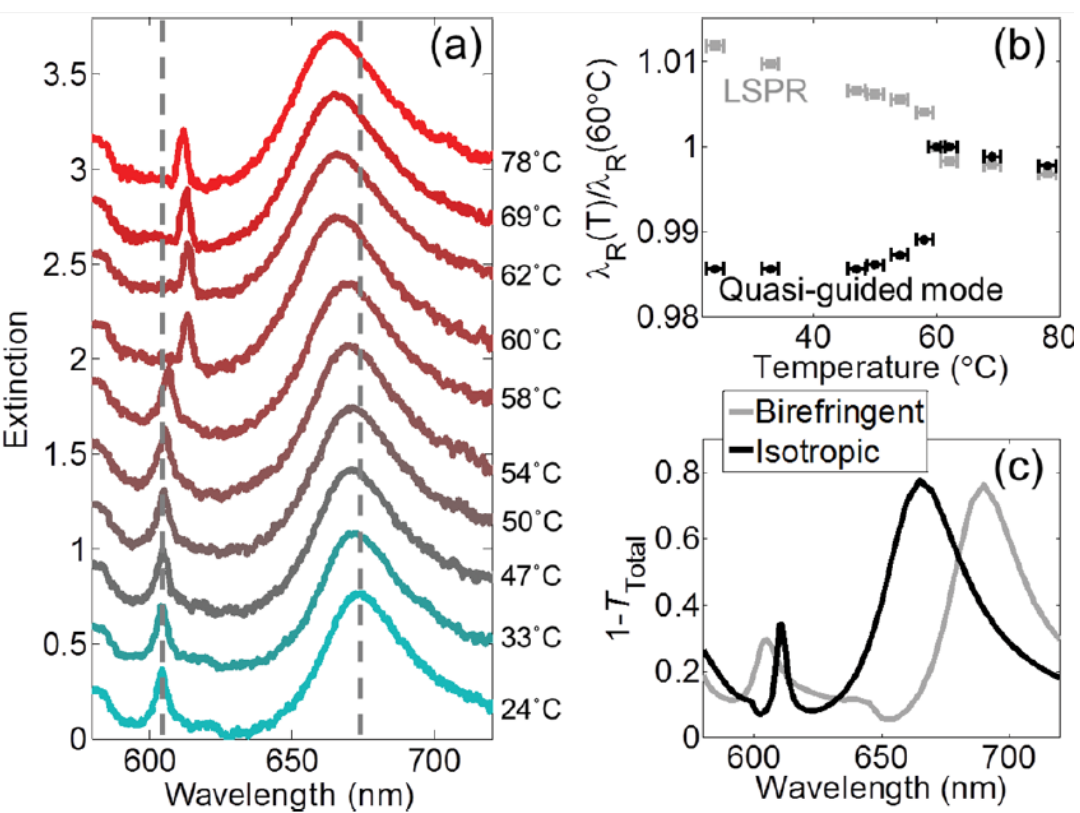
Figure 11. ( a ) Measured extinction as a function of wavelength at different temperatures. ( b ) Temperature-dependent normalization of resonance wavelength to its corresponding wavelength at 60 °C for localized surface plasmon resonance (LSPR) and quasi-guided modes. ( c ) The simulation spectra of two states, where the temperatures of the LCs are set to 24 °C and 60 °C, respectively. Reproduced with permission from [111]. Copyright American Chemical Society, 2014.